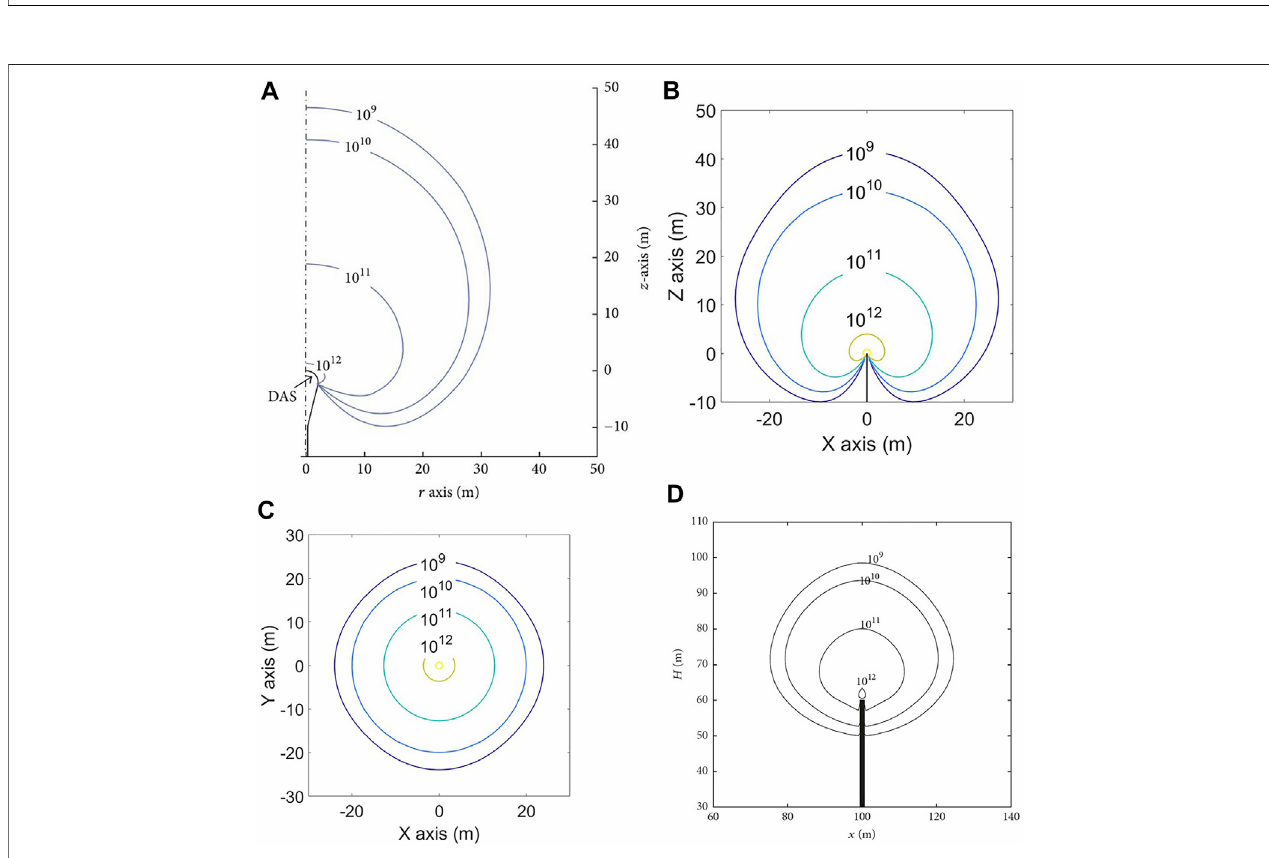
Frontiers in Environmental Science |